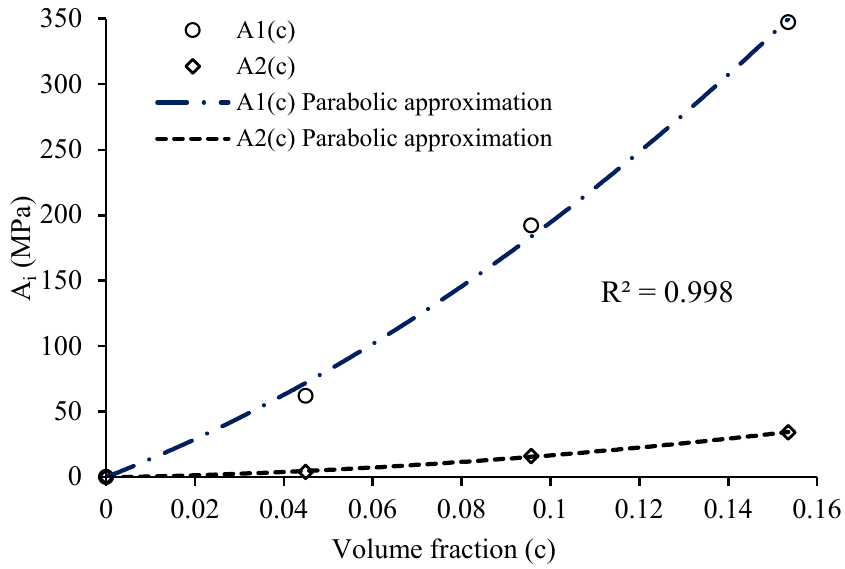
Figure 4. Function A 1 ( c ) and A 2 ( c ) as function of the volume fraction c . ( ) A c and ( ) A c as function of the volume fraction c . Figure 4. Function 1 2 The final whole model parameters are summarized in Table 2. Table 2. Set of anisotropic model Table 2. Set of anisotropic model parameters.